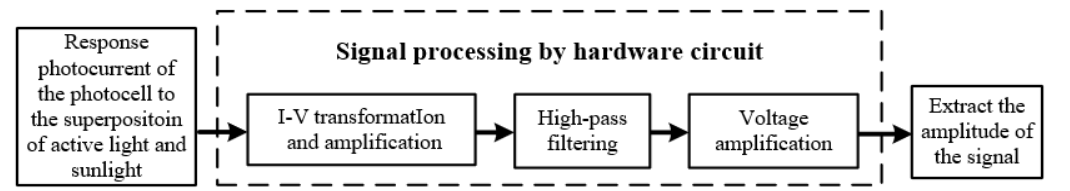
Figure 5. Procedure of processing response signal of the photocell.